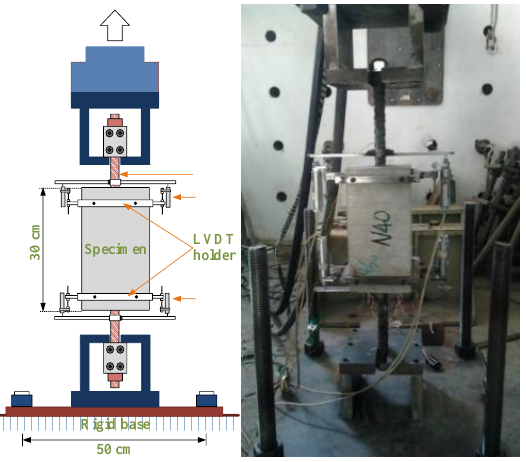
Figure 3. Setup of uniaxial tensile test.